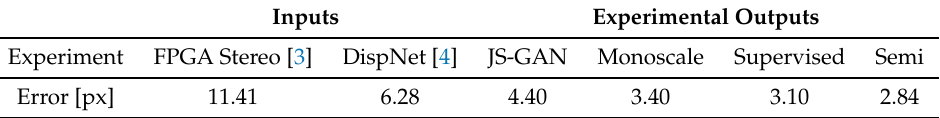
Table 4. Mean absolute disparity error of each model on Synthetic Garden dataset (421 test samples).